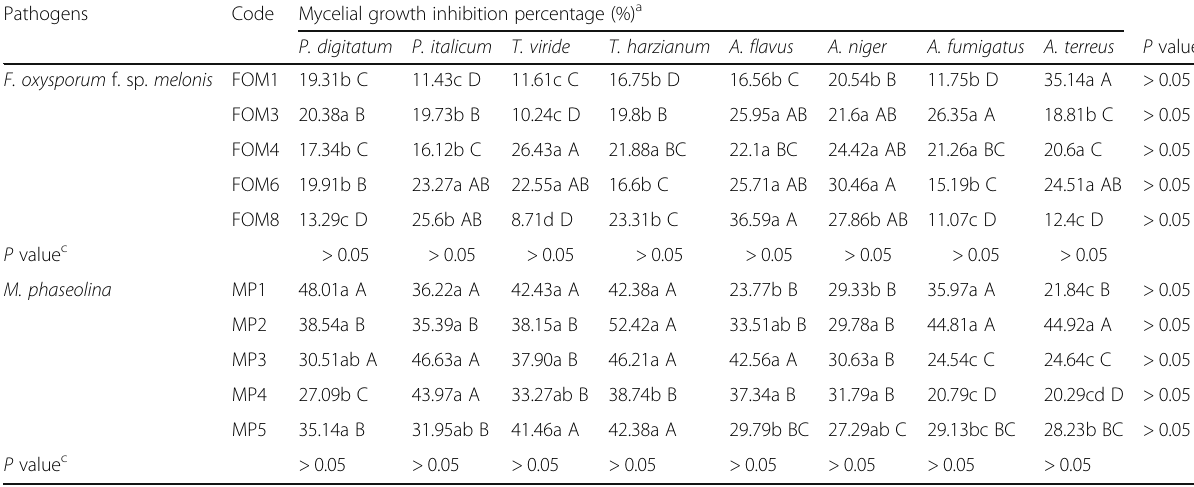
Table 4 Effect of direct confrontation of two Penicillium spp. isolates, two Trichoderma spp. isolates, and four Aspergillus sp. isolates on mycelial growth inhibition of F. oxysporum f. sp. melonis and M. phaseolina after 5 days of incubation at 28 °C, means of six Petri